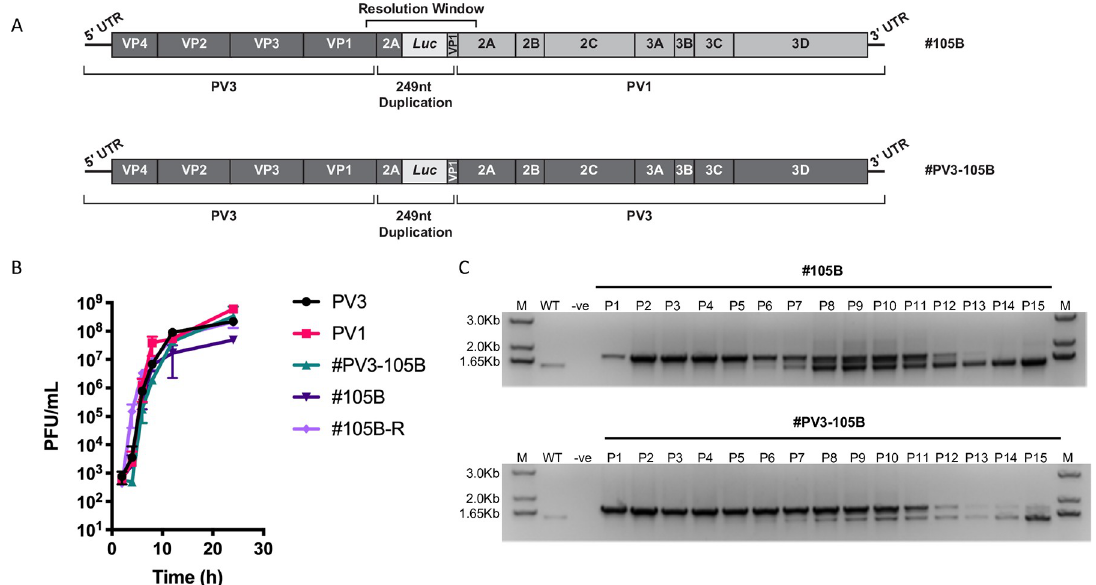
Fig 2. Phenotypic characterisation of intra- and intertypic imprecise recombinants. (A) Schematic representation of the genomes of imprecise recombinants #105B and #PV3-105B. Regions in dark grey are derived from PV3 and regions in light grey are derived from PV1. (B) Replication kinetics of imprecise clones. HeLa cells were infected with virus stock at multiplicity of infection of 5 and virus- containing supernatants harvested over 24 h. Virus titres were determined by plaque assay on HeLa cells. Error bars represent the standard deviation of 3 experiments. (C) Resolution of imprecise recombinant clones. Both #105B (upper panel) and #PV3-105B (lower panel) were serially passaged on HeLa cells for 15 passages. Viral RNA was extracted from supernatants and the potential region of recombination amplified by RT-PCR. The WT lane represents the 1470 nt product generated from a correct-genome length sample.